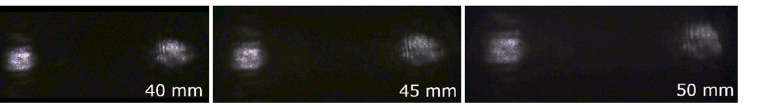
Fig 3. Pictures of the spots on the paper screen recorded at three distances of the CLP: 40 mm, 45 mm, and 50 mm.